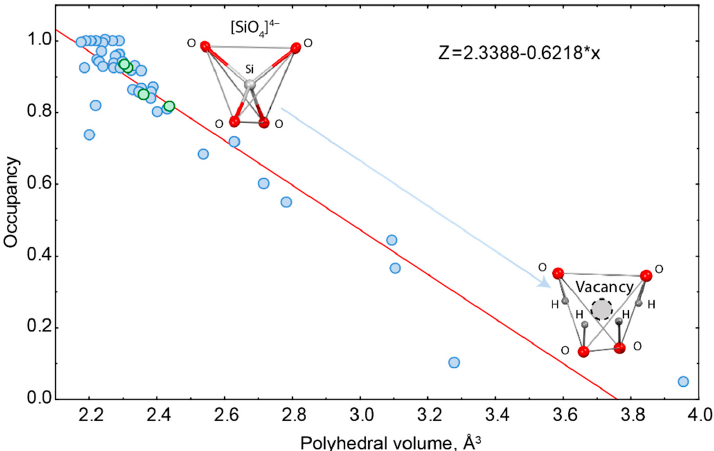
Figure 5. The polyhedral volume of Z sites vs. an occupancy diagram for the (H 4 O 4 ) 4 − -substituted garnets (light blue circles) according to [18,32] and data of the present work for the I 42 d model (light green circles).